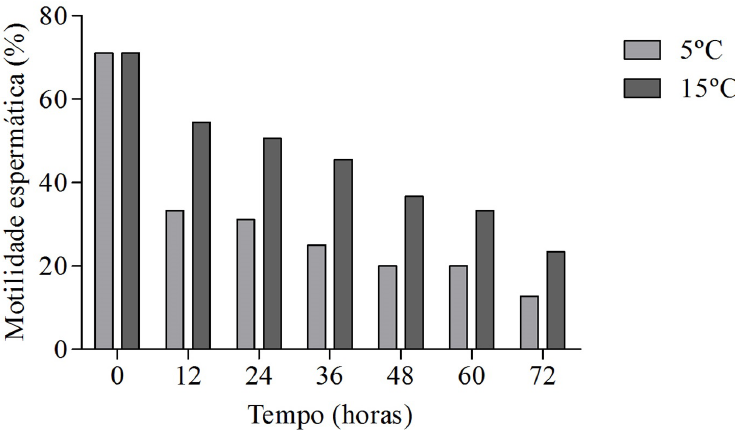
Figura 3. Médias de motilidade (%), das amostras de sêmen submetido à refrigeração nas temperaturas 5 ou 15